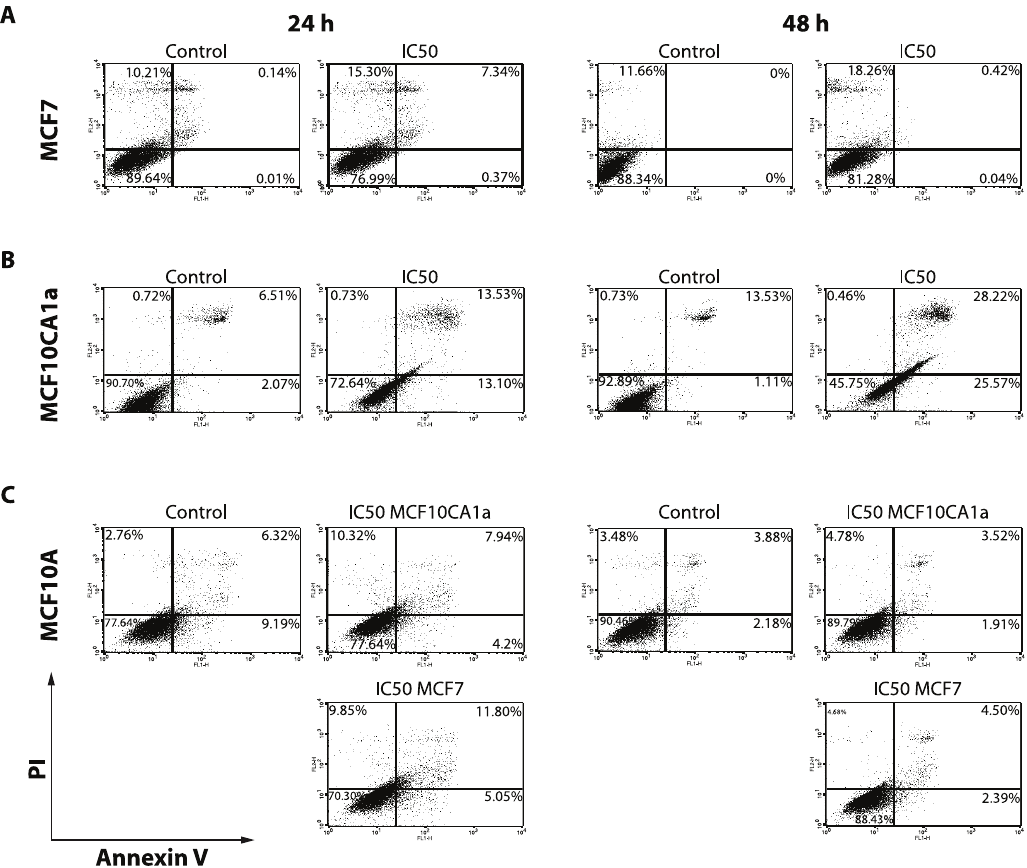
Figure 3. Buxus extract induces autophagy in cancer cells as evidenced by PI/Annexin V double staining and FACS analysis. A–B. PI/ Annexin V double staining of untreated and treated MCF7 (A) and MCF10CA1a (B) cells with IC 50 concentration for 24 h and 48 h. C. FACS analysis with PI/Annexin V double staining of MCF10A cell line (control cell line) treated with MCF7 and MCF10CA1a IC 50 respective Buxus extract concentrations for 24 h and 48 h.